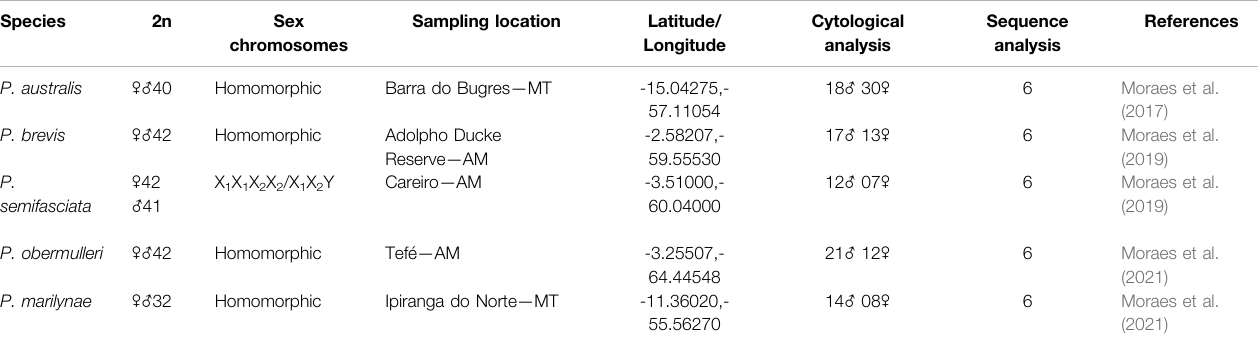
TABLE 1 | Species, diploid numbers (2n), sex chromosome systems, numbers of individuals cytogenetically analyzed, and the number of individuals sequenced. Species 2n Sex Sampling location Latitude/ chromosomes